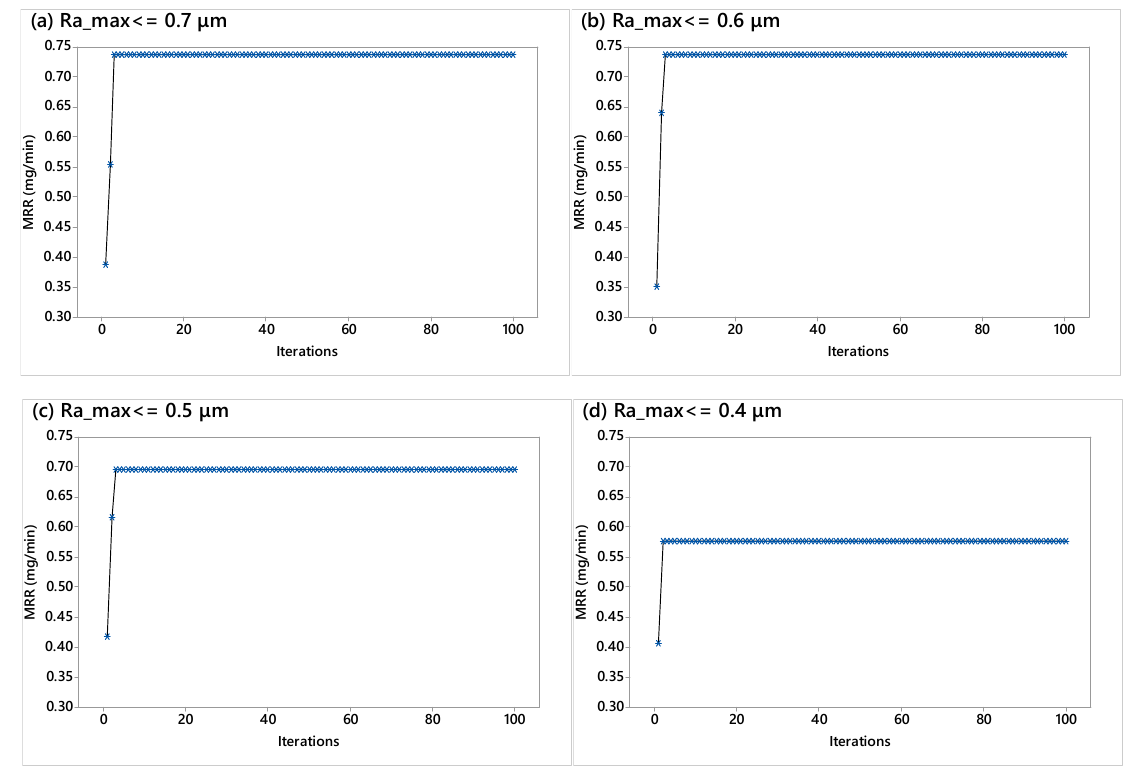
Figure 3. Convergence graphs for optimizing the conventional abrasive flow nano-finishing process [2] using VEGA, under the constraint of: ( a ) Ra_ max ≤ 0.7 μm, ( b ) Ra_ max ≤ 0.6 μm, ( c ) Ra_ max ≤ 0.5 μm, and ( d ) Ra_ max ≤ 0.4 μm.